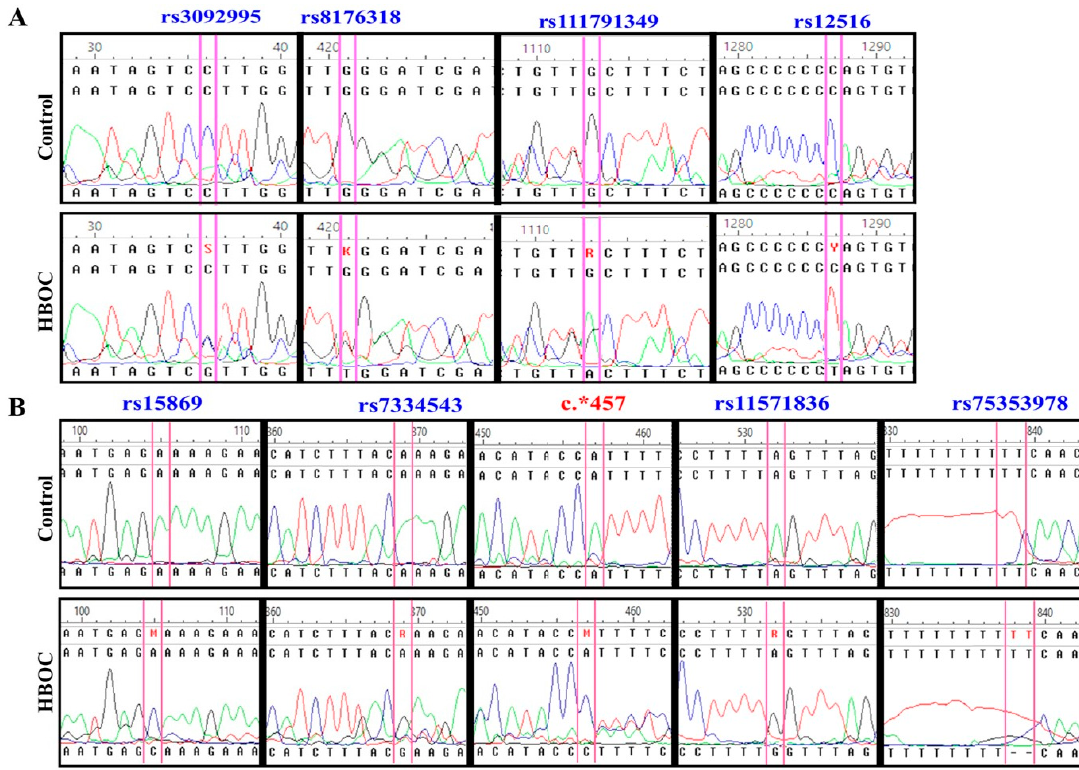
Figure 1. Identification of variants’ single nucleotide polymorphisms (SNPs). Allelic variants of each 3’UTR region were identified by comparing the alleles carrying the HBOC and healthy patients; blue legends indicate SNP previously reported; red legend indicate a new genetic variant. ( A ) Comparison of 3’UTR of BRCA1 ; ( B ) Comparison of 3’UTR of